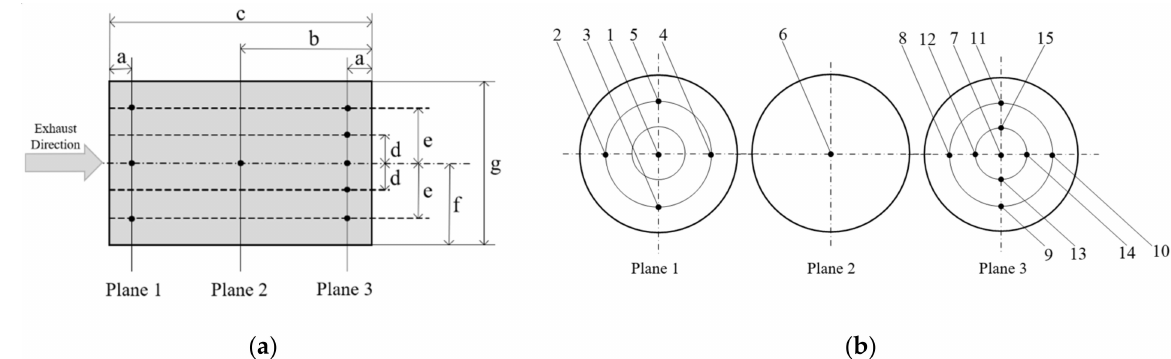
Figure 10. Distribution of monitoring points. ( a ) Radial view of temperature sensor locations inside DPF. a: 20 mm b: 63.5 mm c: 127 mm d: 31.8 mm e: 63.5 mm f: 95.3 mm g: 190.5 mm. ( b ) Axial view of temperature sensor locations inside DPF.